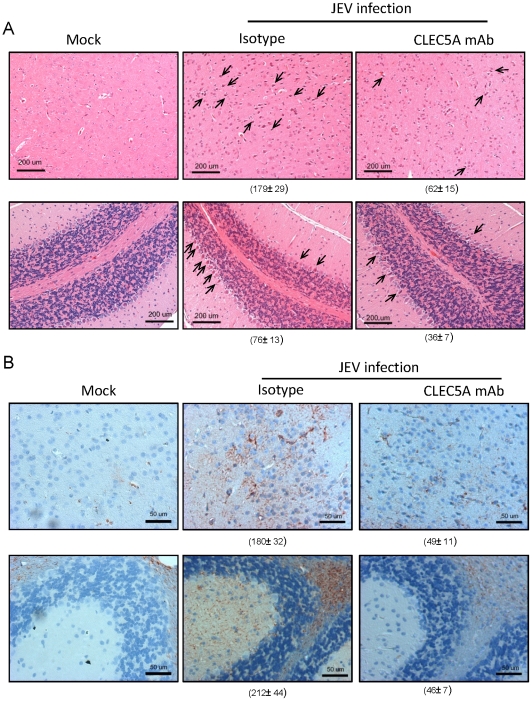
Anti-CLEC5A mAb rescues JEV-induced neuronal damage.(A): JEV-induced pathological changes were examined by H&E staining. Arrowheads indicate dysmrophic neurons in the cerebral cortex (upper panel) and damaged Purkinje cells in the cerebellum (lower panel), scale bars, 200 µm. (B) Neuronal damage induced-astrogliosis was characterized by GFAP staining, scale bars, 50 µm. For (A) and (B), tissues were harvested at day 5 post JEV infection. Five random fields of views in medium power field (original magnification (OM)×200) were photographed, and the numbers of dysmorphic neurons or GFAP+ cells in cerebral cortex and cerebellum in each sample were counted, summed up and represented as mean ± s.e.m. (under each picture) of four independent experiments.